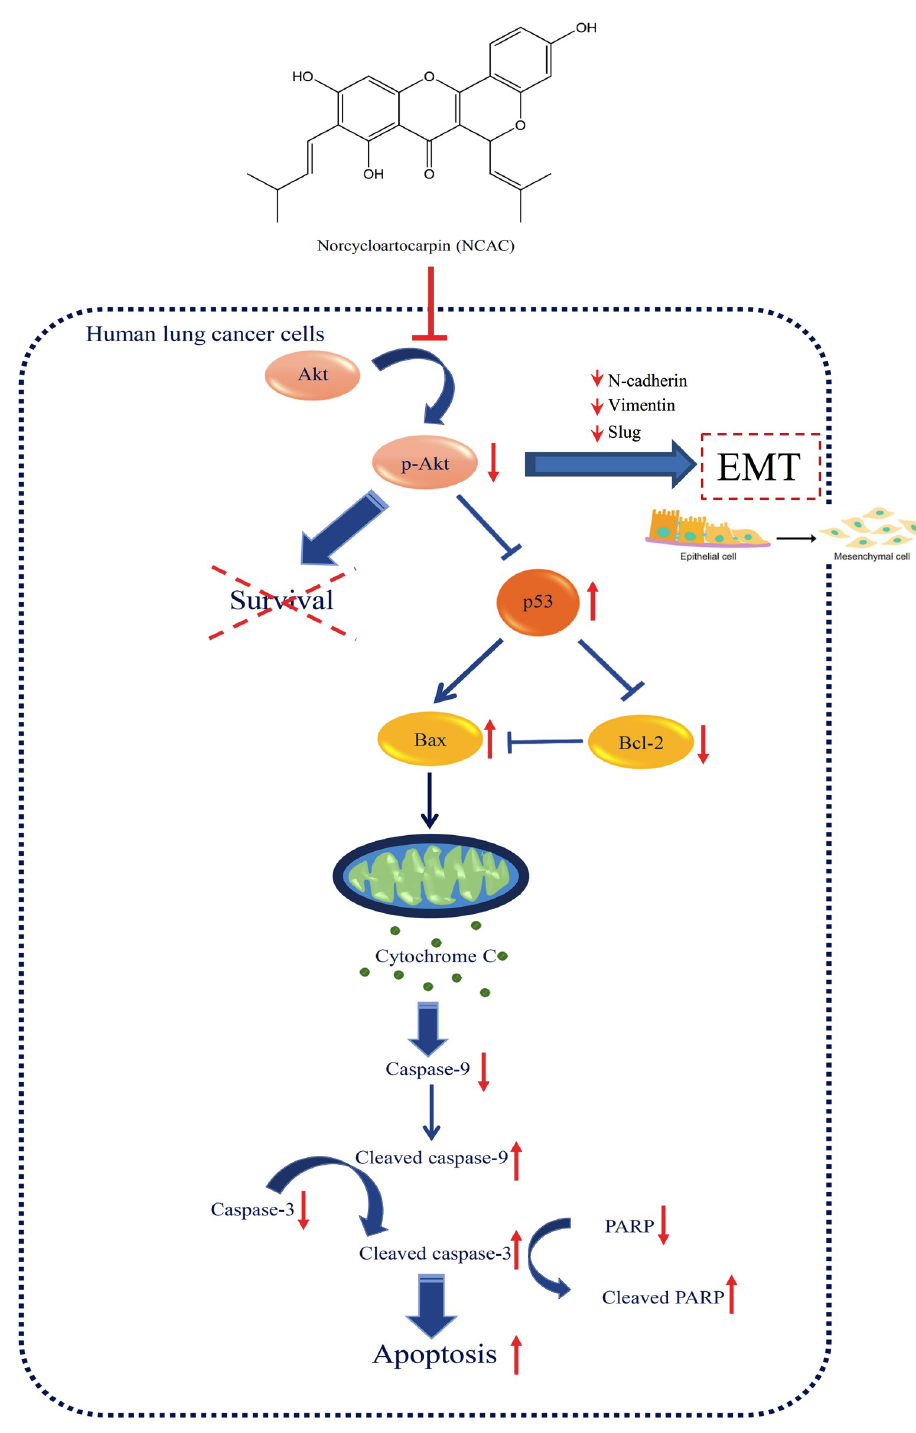
Fig 7. The proposed regulatory pathway involving in anticancer activity of norcycloartocarpin in human lung cancer cells. The mechanism of norcycloartocarpin in suppression of the migration and EMT signals in lung cancer cells. Norcycloartocarpin triggers apoptosis via Akt-modulating p53 activation following with down-regulation of Bcl- 2 and increase of Bax. Moreover, the suppression on p-Akt/Akt survival signal mediated by norcycloartocarpin resulted in the restraint of survival ability and colony formation in human lung cancer cells.